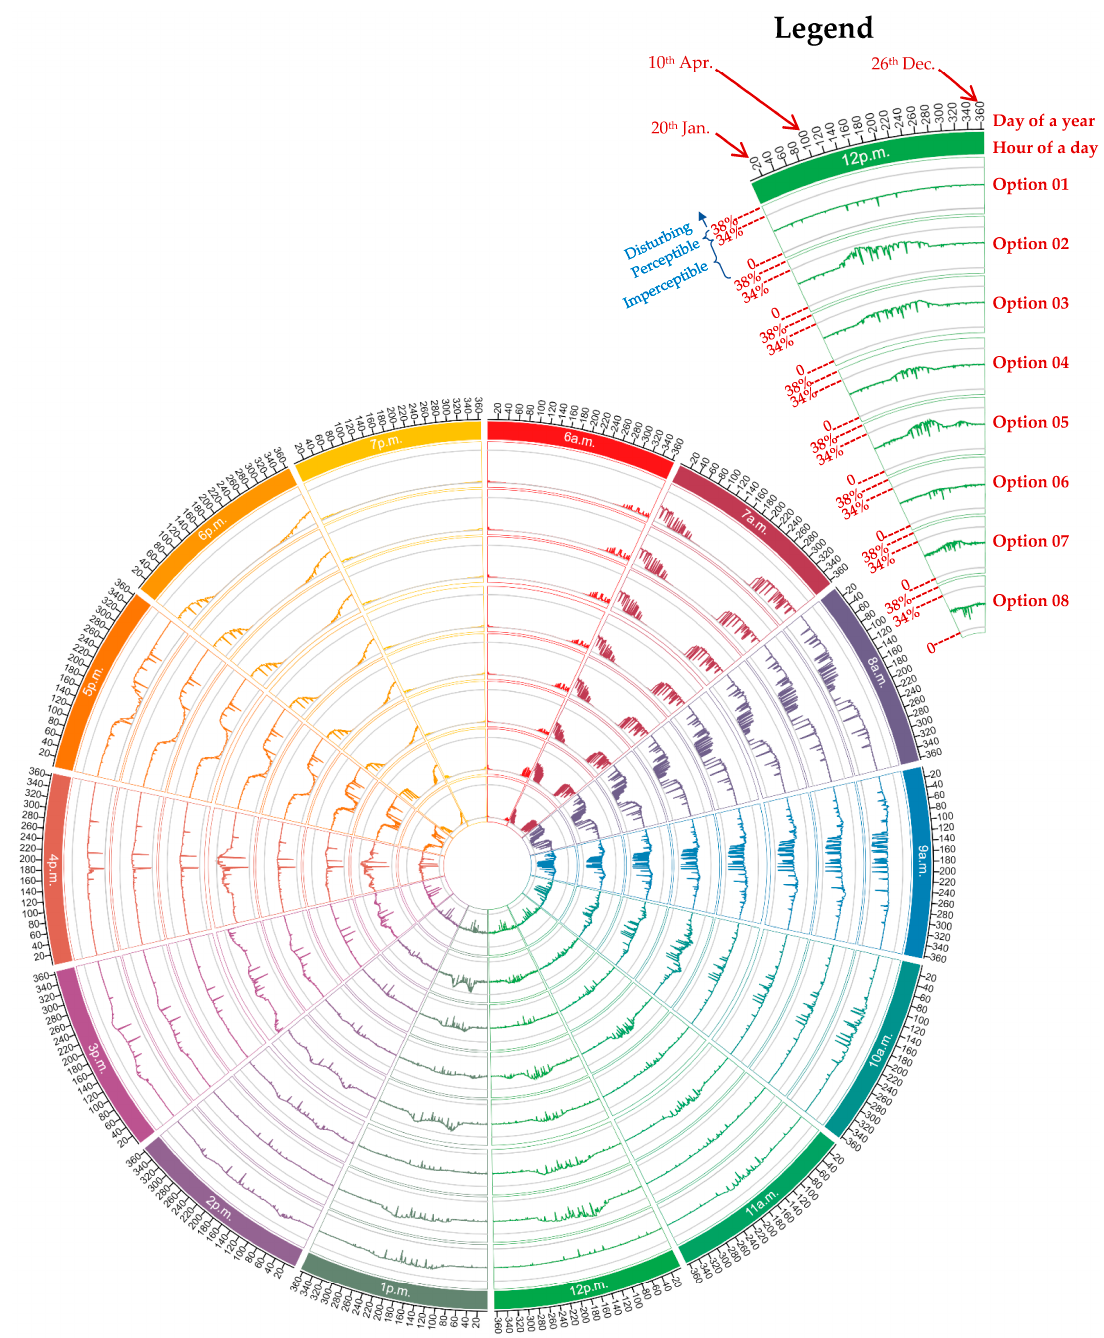
Figure 9. In-depth hourly analysis of DGP for all near-optimum options for each hour of the day.